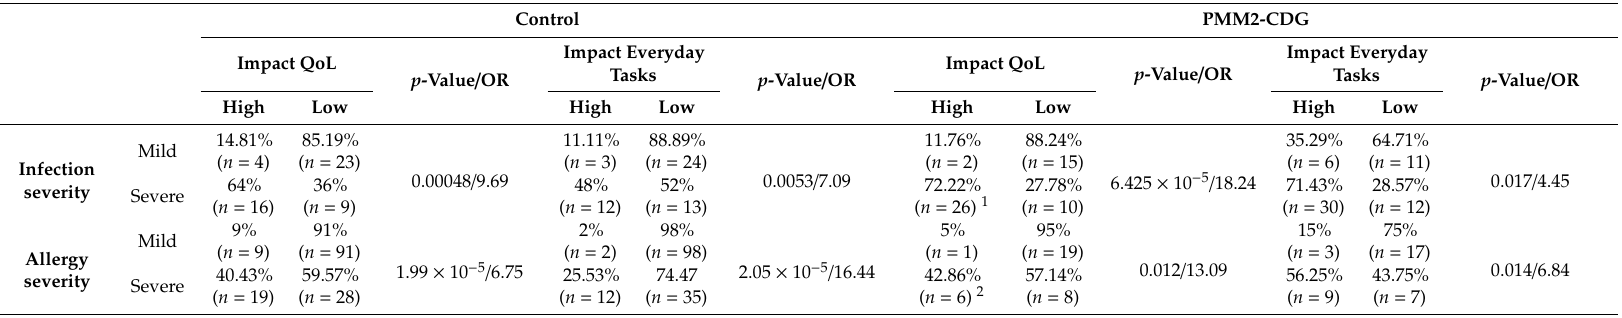
Table 1. Correlation between perceived infection / allergy severity and quality of life (QoL) impact on PMM2-CDG and control groups. The options “No impact” and “Slightly negative” were combined, forming the “Low impact” group. The same was done for “Negative” and “The most impactful health-related factor” constituting the “High impact” group. Statistical significance was determined with Fisher’s exact test. p -values and OR are